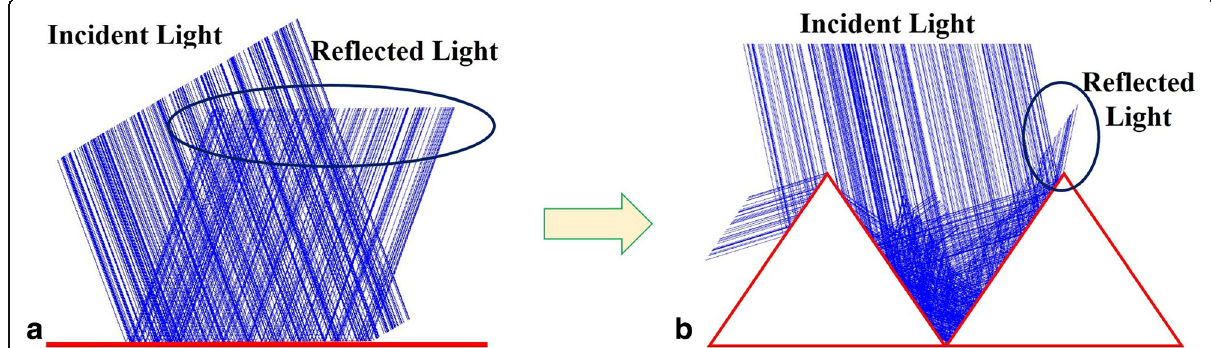
Fig. 1 Model of infrared mechanism. a Light was incident on the flat film; b on the triangular